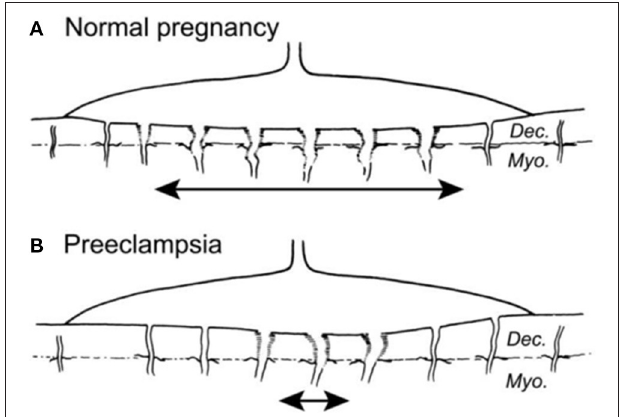
FIGURE 5 | (A) Normal placental bed with full transformation of the myometrial spiral arteries except at the periphery of the placental bed (B) . Defective deep placentation is characterized by non-transformation of the myometrial spiral arteries reducing the central area with deep placentation